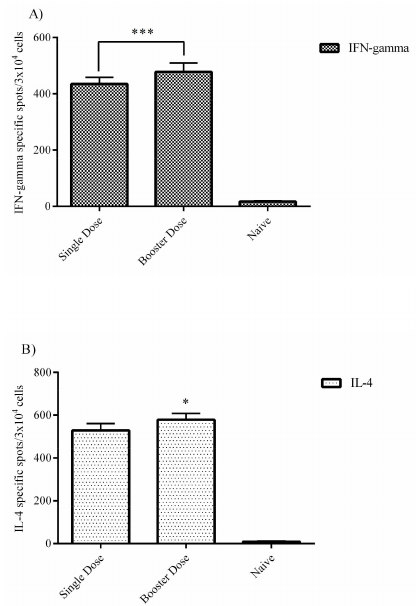
Figure 3. ELISPOT assays. ( A ) Splenocyte cells from immunized C57BL / 6 were obtained on week four after immunization. IFN-gamma secretion was analyzed by ELISPOT assay. The number of IFN-gamma specific spots in the booster dose group was higher than for the single dose. ( B ) The number of IL-4-specific spots was similar to that for IFN-gamma. This indicates that the booster dose had a stronger e ff ect than the single dose. The data was analyzed using the log-rank test (* P < 0.05; ** P < 0.01; and *** P < 0.001) and presented as mean ± SD. Error bars indicate standard deviations